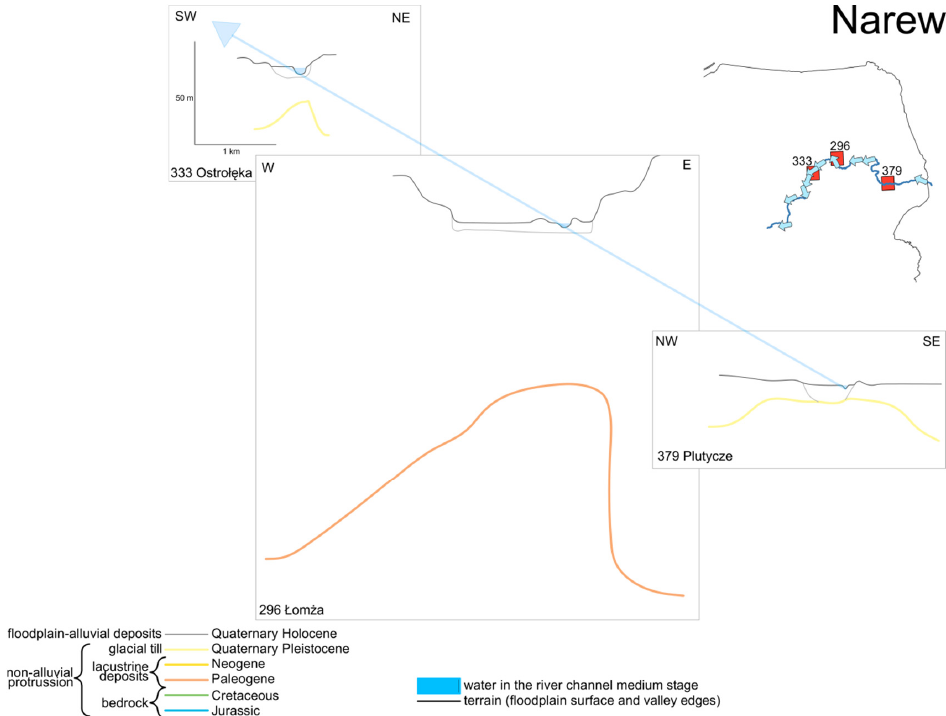
Figure 2. Geological cross-sections through the Bug river valley, according to [49,50]. Each cross-section presents: water in the river channel during medium stage (blue body); schematic river channel with flow direction (blue line) the valley profile graph with the floodplain surface and the valley’s walls (black), alluvial cover of the floodplain (grey) and non- alluvial protrusion underneath. The color of the non-alluvial protrusion indicates its age according to the stratigraphic chart [43].